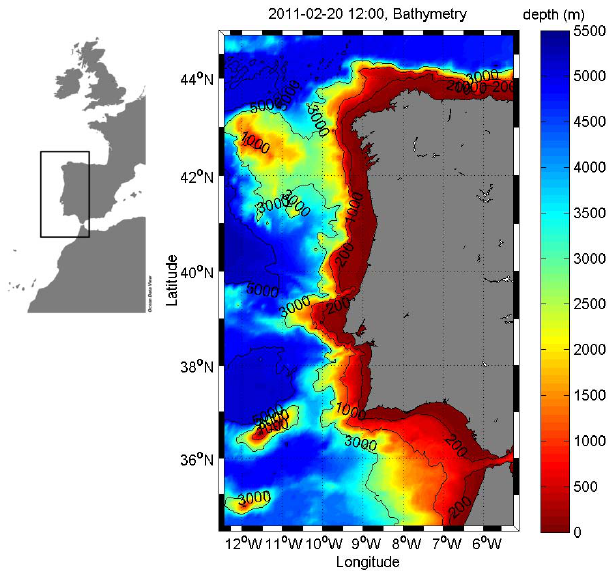
Fig. 1. West Iberia baroclinic model bathymetry bounded by 5.5 ◦ – 12.6 ◦ W and 34.4 ◦ –45.0 ◦ N, and with a 0.06 ◦ spatial resolution. Baseline data from SRTM